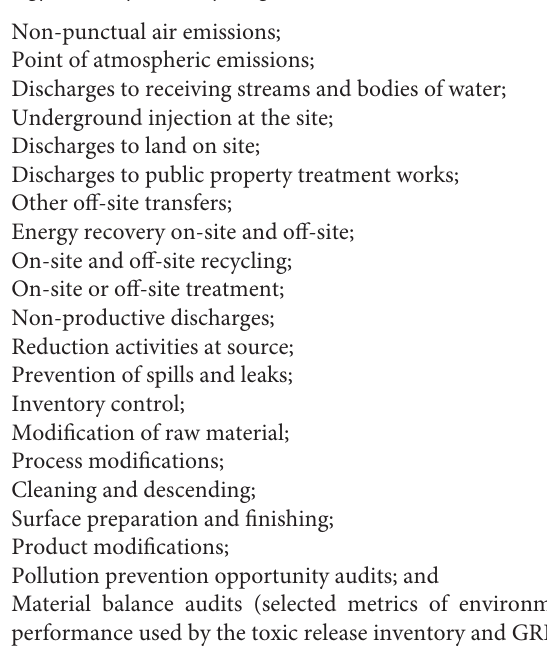
that were considered in each perspective (financial, customer, internal and external business process, learning, and